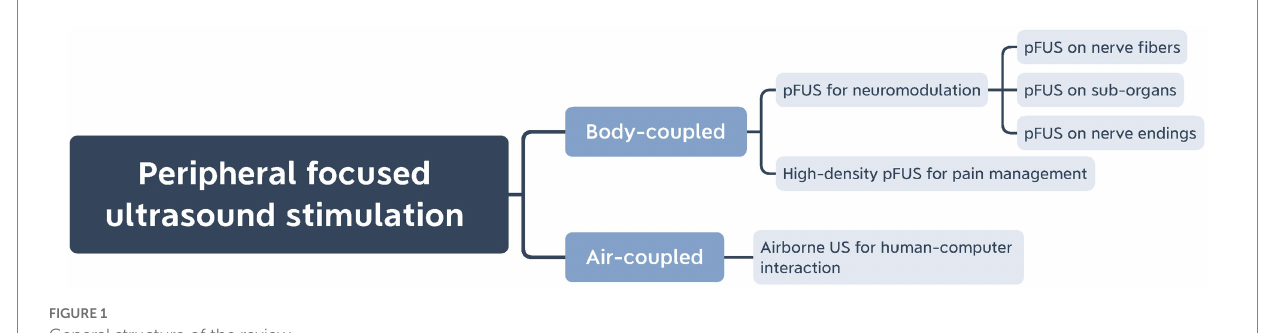
FIGURE 1 General structure of the